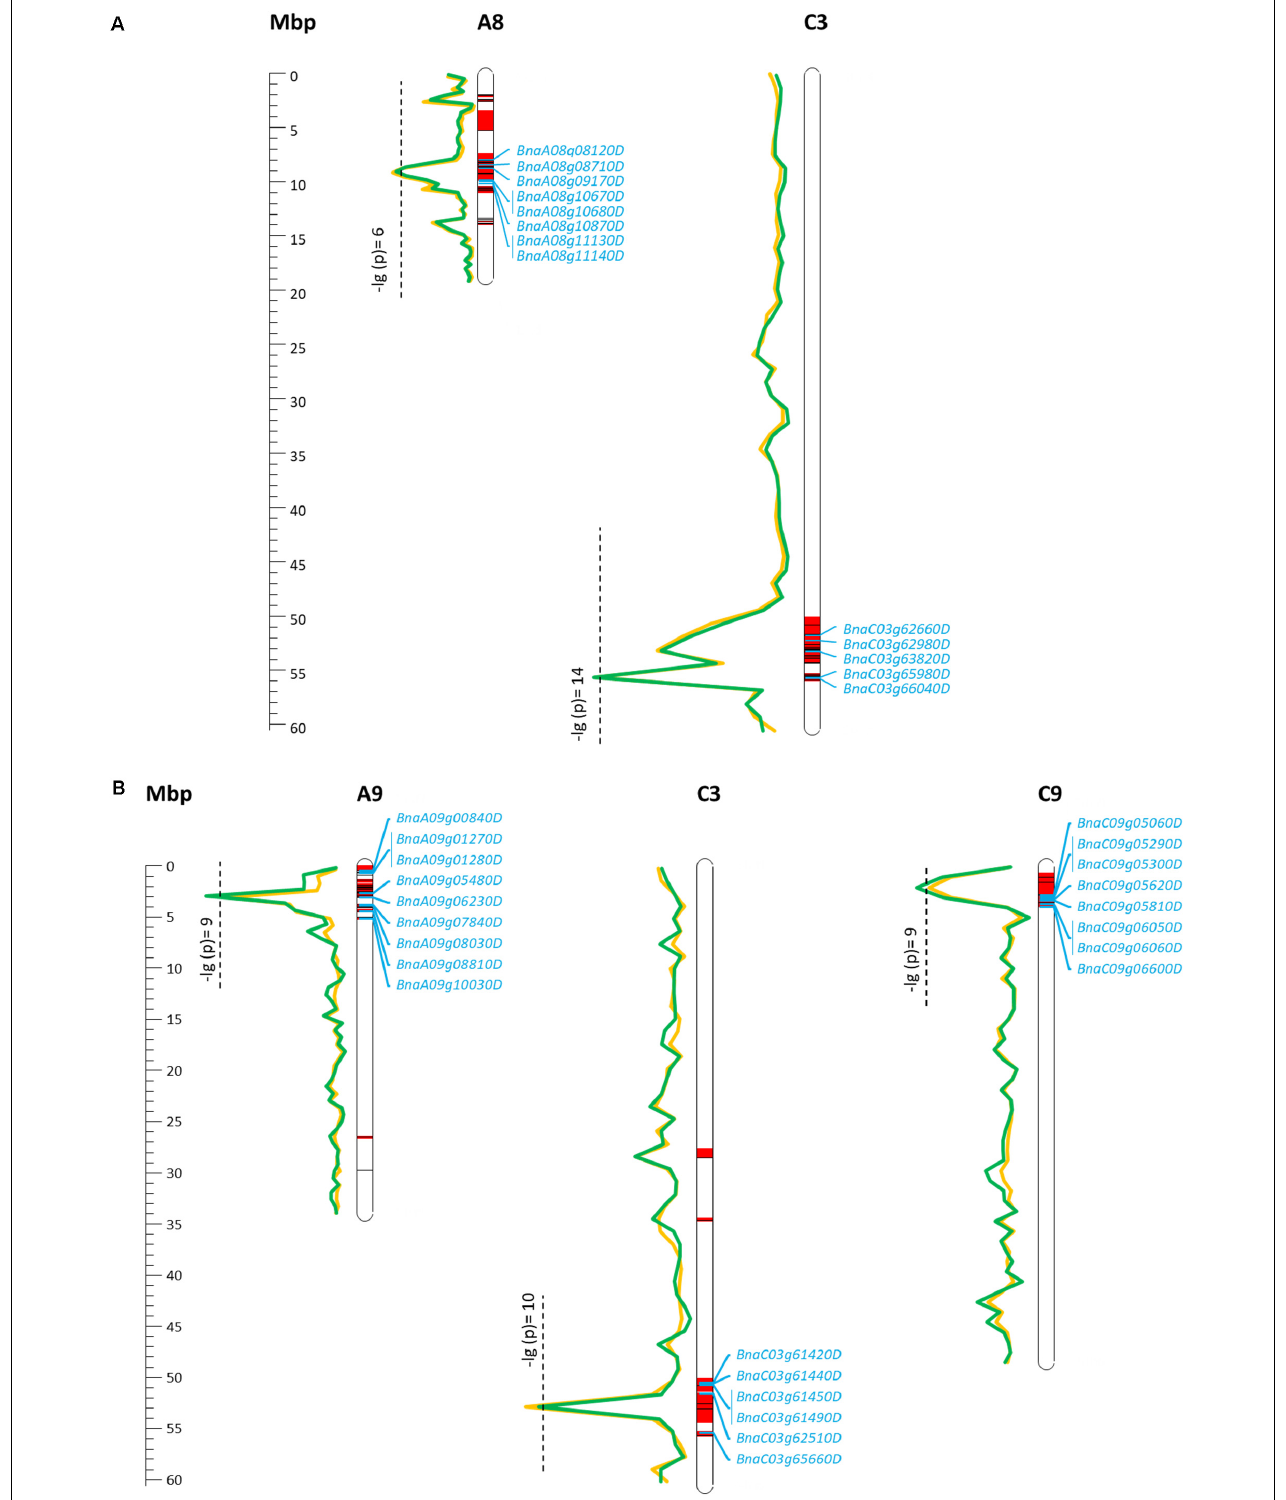
FIGURE 6 | Main marker–trait associations calculated for seed erucic acid content (A) and seed glucosinolate content (B) within a diverse set of winter oilseed rape genotypes. Calculated − lg( p ) values for the two observed seed lots were represented by a green (SL2011) and a yellow line (SL2012). Confidence intervals harboring associated SNP markers and SNP markers which are in LD ( r 2 > 0.4) to an associated marker are shown in red. Candidate genes enclosed by the confidence regions are shown in blue.